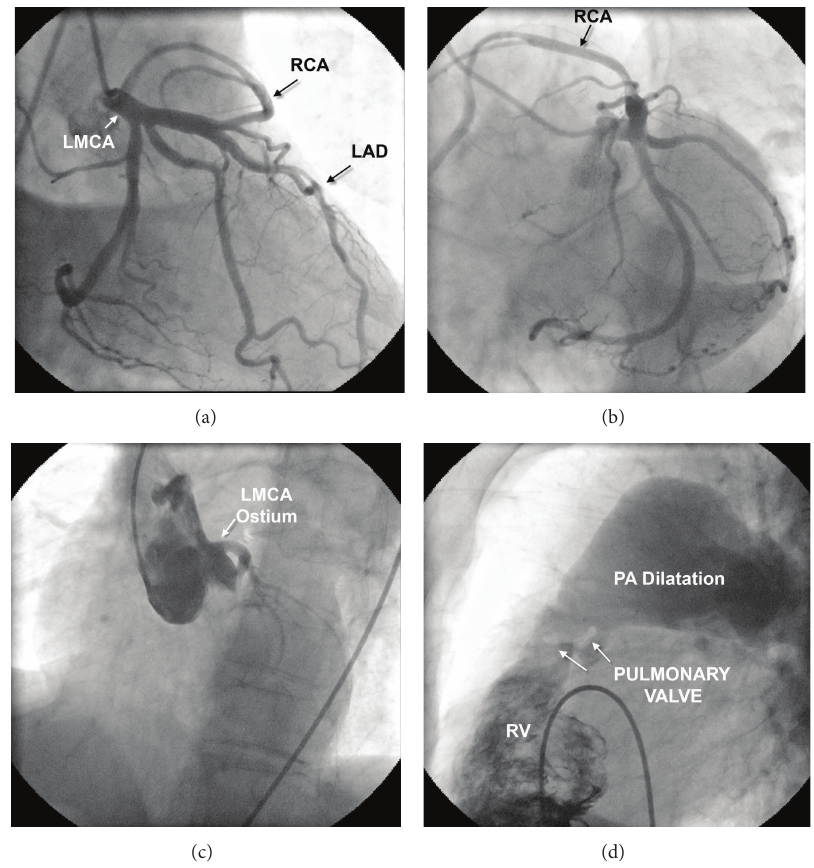
Figure 1: (a) Right anterior oblique view with caudal angulation. The RCA originates from the proximal portion of the LAD and travels to the right ventricle area. (b) Left anterior oblique view. The course of the anomalous RCA after its origin from the LAD. (c) Left anterior oblique view. Aortic root angiography revealed no coronary artery arising from the right sinus of Valsalva. (d) RV and PA angiogram showing calcific pulmonic valve (arrow) with poststenotic dilatation of the pulmonary arteries. RCA: right coronary artery. LAD: left anterior descending artery. RV: right ventricle. PA: pulmonary